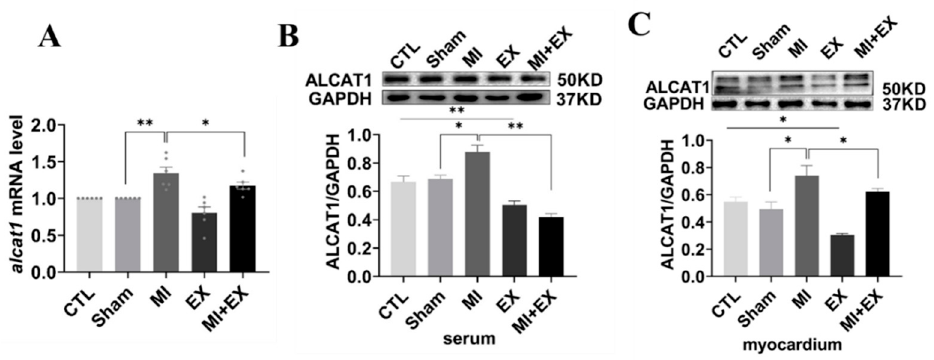
Figure 7. mRNA and protein expression of ALCAT1. ( A ) Quantitative reverse transcription poly- merase chain reaction (RTq-PCR) analysis of ALCAT1 expression in the heart ( n = 6). ( B , C ) Western blot images of ALCAT1 protein in the serum and heart and densitometric analysis of the bands ( n = 3). The values are presented as the mean ± SEM. CTL, normal control; MI, myocardial infarct; EX, CTL + exercise; MI + EX, MI+ exercise. * p < 0.05, ** p < 0.01.